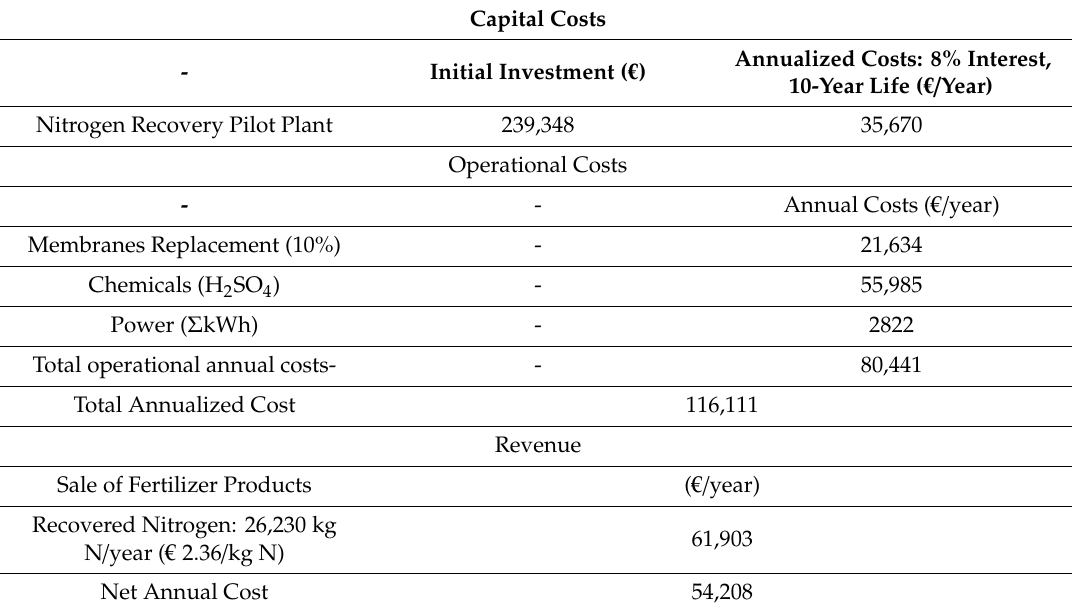
Table 5. Summary of capital costs and revenues of the pilot plant gas-permeable membrane